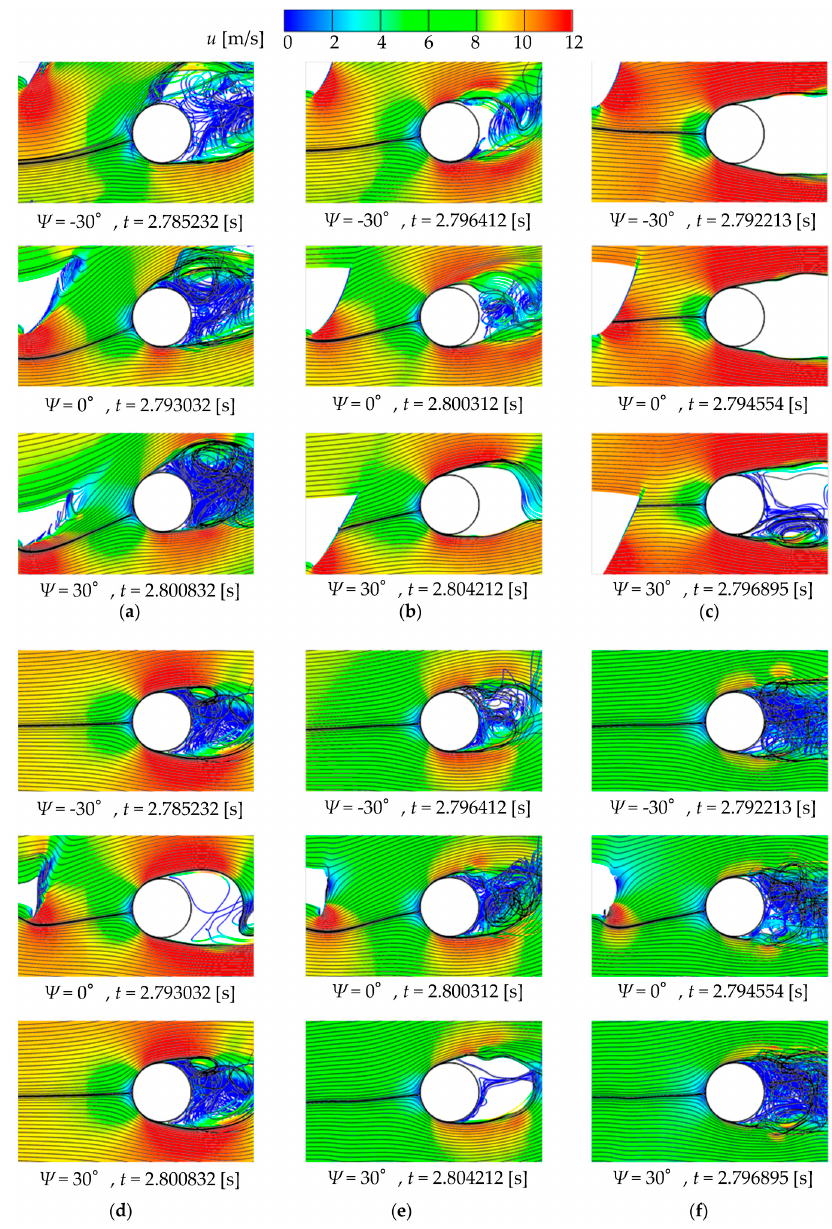
Figure 8. Instantaneous streamlines passing the line parallel to the y axis and tangential to the tower on its upwind side at the mid-heights of segments 1 and 4. The circle indicates the cross-section of the tower. ( a ) λ = 3, Segment 1; ( b ) λ = 6, Segment 1; ( c ) λ = 10, Segment 1; ( d ) λ = 3, Segment 4; ( e ) λ = 6, Segment 4; and ( f ) λ = 10, Segment 4.